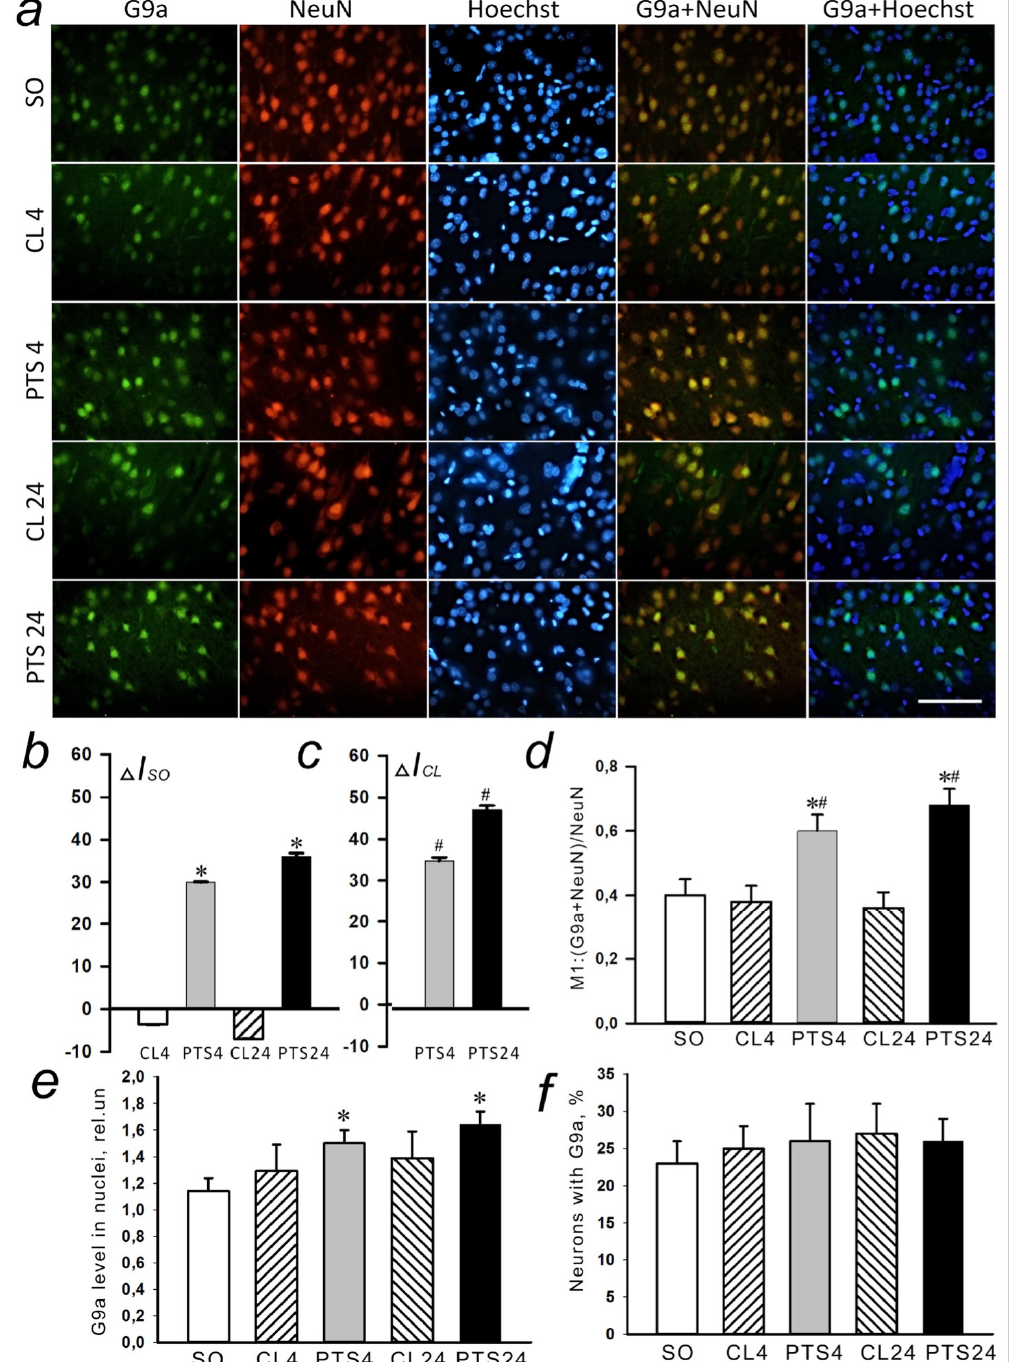
Figure 8. The changes in G9a localization and levels in the neurons of ischemic penumbra at 4 and 24 h after photothrombotic stroke (PTS) in the rat cerebral cortex. The localization of G9a at 4 and 24 h after PTS (PTS4 and PTS24, respectively) compared to the contralateral cortex of the same animals (CL4 and CL24), or the cerebral cortex of sham-operated rats (SO). ( a ) Immunofluorescence of G9a (green), neuronal marker NeuN (red), nuclear chromatin marker Hoechst 33342 (blue), and image overlay. The scale bar is 50 μ m. ( b ) Percent changes ( Δ ISO) of G9a levels in the penumbra (PTS4 or PTS24) and CL4 or CL24 compared to SO. ( c ) Percent changes ( Δ ICL) of G9a levels in the penumbra (PTS4 or PTS24) compared to CL4 or CL24. ( d ) Coefficient M1 of G9a co-localization with the neuronal marker (NeuN) in different control and experimental groups. ( e ) Immunofluorescence of G9a in cell nuclei. ( f ) Percentage of cells expressing G9a per 100 cells stained with Hoechst 33342 * p < 0.05 compared to SO, # p < 0.05 compared to CL4 or CL24. One Way ANOVA; M ± SEM; n =